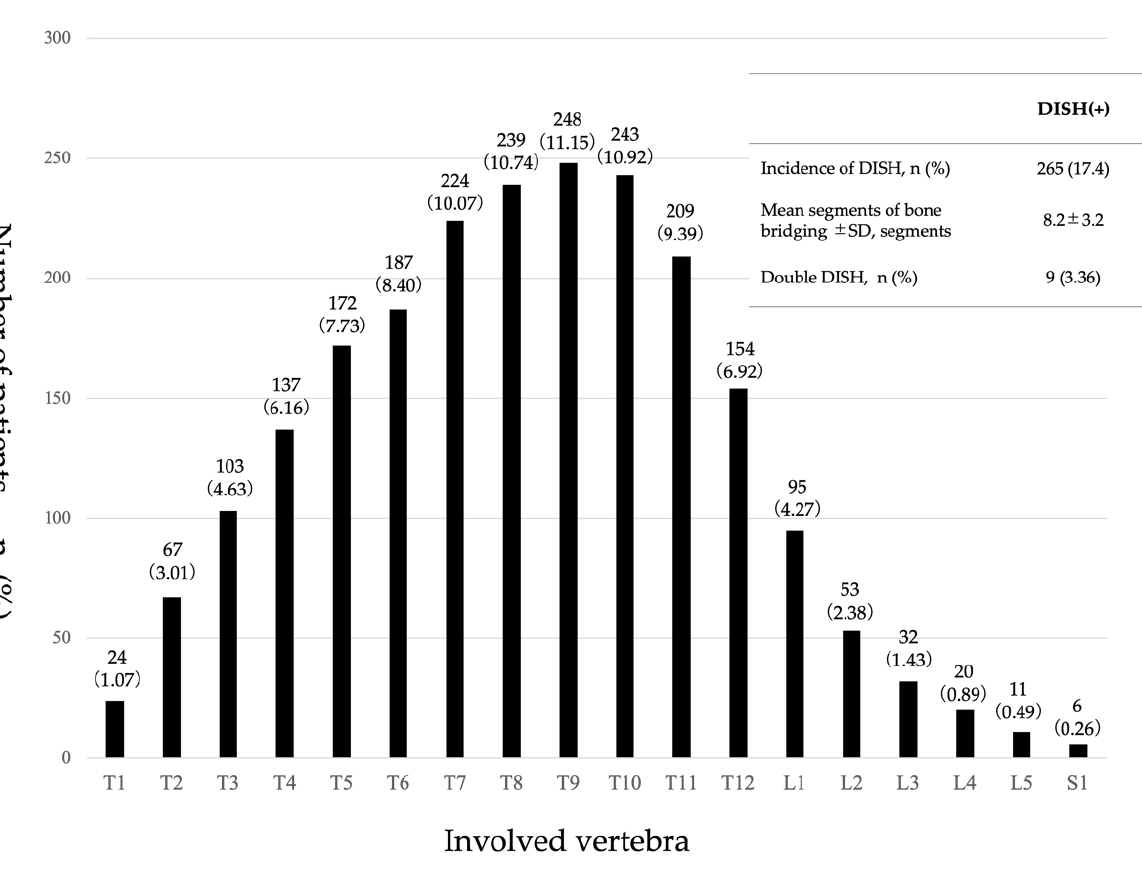
Figure 3. Distribution of DISH. The prevalence of DISH is 17.4%, with DISH observed in all of the segments from the T1 vertebra to the first sacral vertebra. The frequency of the occurrence in the thoracic spine was higher than in the lumbar spine, with a concentration in the thoracolumbar junction. The prevalence of DISH was particularly high (11.1%) in T9 vertebra. Bone bridging was observed in 8.2 ± 3.2 vertebrae on average, and there were 9 cases (3.3%) that showed double DISH. The mean age of the patients was 78.8 ± 10.1 years in the DISH (+) group and 67.8 ± 19.5 years in the DISH ( − ) group, and the patients in the DISH (+) group were significantly older compared to the DISH ( − ) group ( p < 0.001). Regarding the gender ratio, there were 185 males (69.8%) and 80 females (30.2%) in the DISH (+), and 646 males (51.6%) and 608 females (48.5%) in the DISH ( − ) group, with a significantly higher ratio of males in the DISH (+) group ( p < 0.001). The mean BMI was 22.1 ± 4.3 kg/m 2 in the DISH (+) group and 23.4 ± 3.7 kg/m 2 in the DISH ( − ) group, and there was no significant differ- ence between the groups (Table 1). From these results, there was a statistically significant difference in age and gender among the patients’ demographic data in these two groups. Therefore, the propensity score matching was used to perform the sample matching with age and gender as confounding factors. Ultimately, the DISH (+) group contained 188 cases (mean age: 78.8 ± 9.5 years, 65.4% male, mean BMI was 22.2 ± 4.4 kg/m 2 ), while the DISH ( − ) group contained 188 cases (mean age: 79.3 ± 9.5 years, 62.2% male, mean BMI was 20.5 ± 4.0 kg/m 2